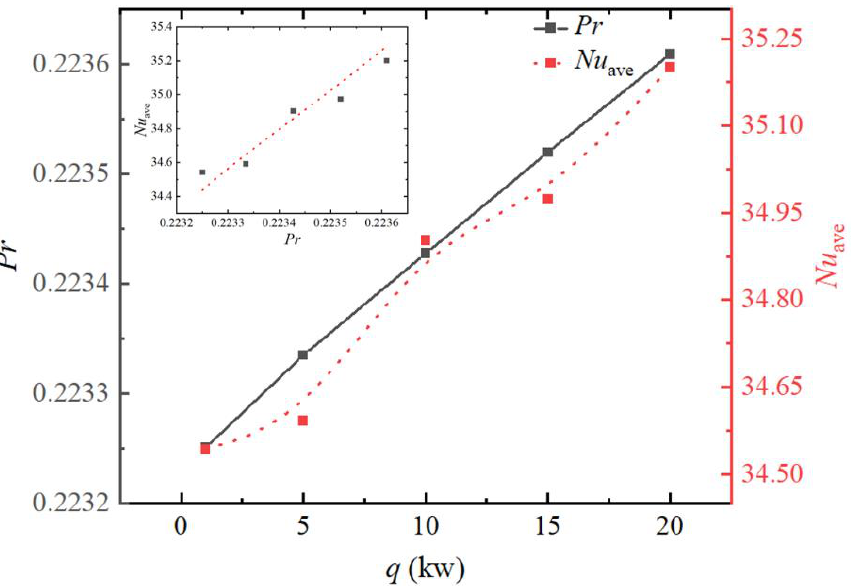
Figure 18. Influence of the He–Xe property on heat transfer capacity ( Re in = 6000, A = tan 57.5° , and 29% Xe).